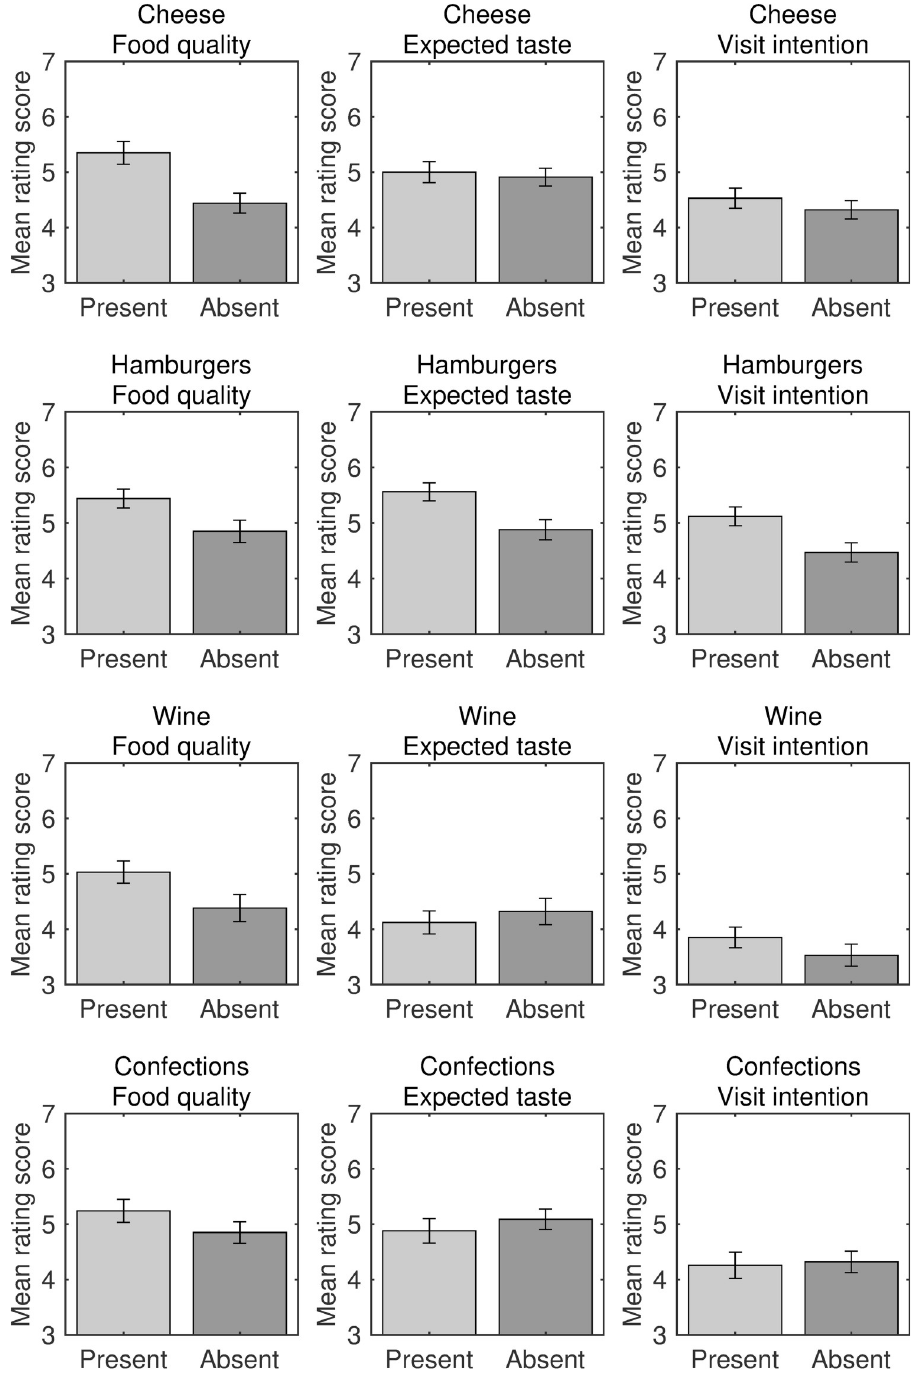
Fig 7. Evaluations of food shops in Experiment 3. Bar plots for visit intention, expected taste, and food quality ratings, and types of foods (i.e., cheese, hamburgers, wine, and Japanese confections), are shown separately for the label present and label absent conditions. Error bars indicate standard